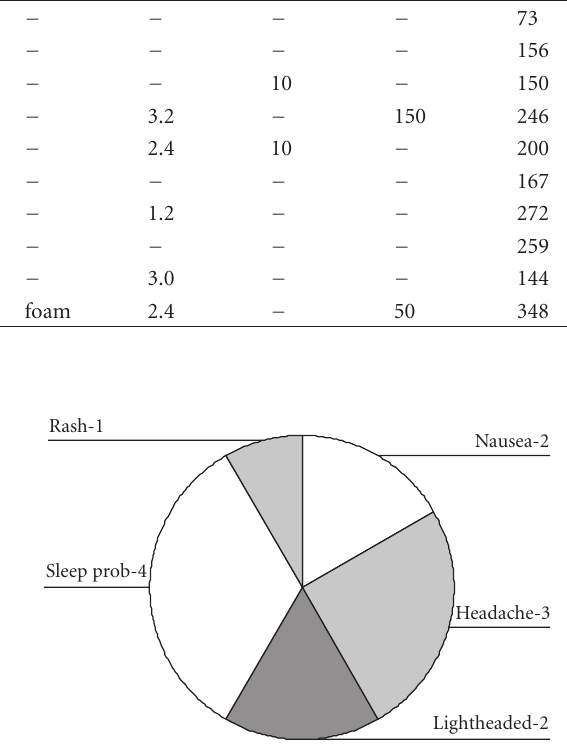
Figure 2: Adverse events during study. Adverse events experi- enced during nicotine enema treatment with the number of pa- tients a ff ected in each case. “Sleep prob” refers to disturbed sleep or vivid dreams. The “rash” was a 2 cm diameter erythematous macu- lopapular lesion on the forearm of a patient which resolved sponta-